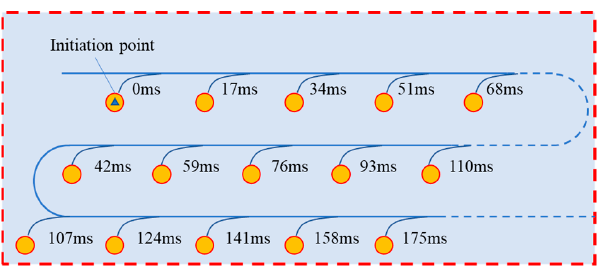
Figure 5. Diagram of initiation network.